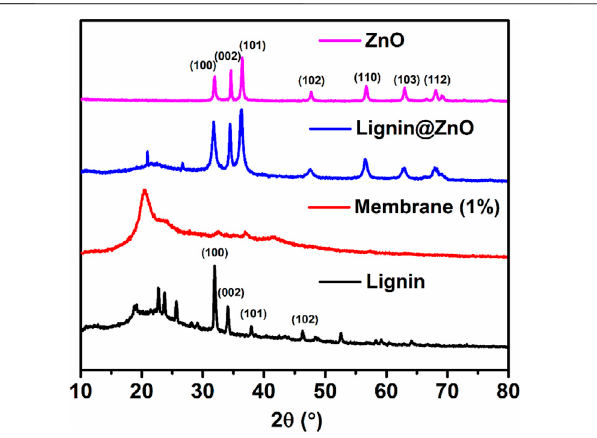
FIGURE 2 | The UV – visible spectrum of lignin, Lignin@ZnO, 1, 2.5, and 5% Lignin@ZnO-GTR membranes. FIGURE. 3 | XRD spectra of synthesized ZnO NPs, Lignin@ZnO, Lignin,